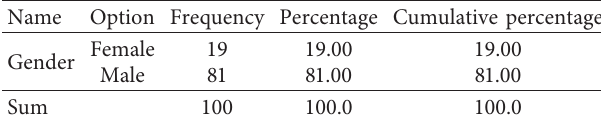
Table 2: Frequency